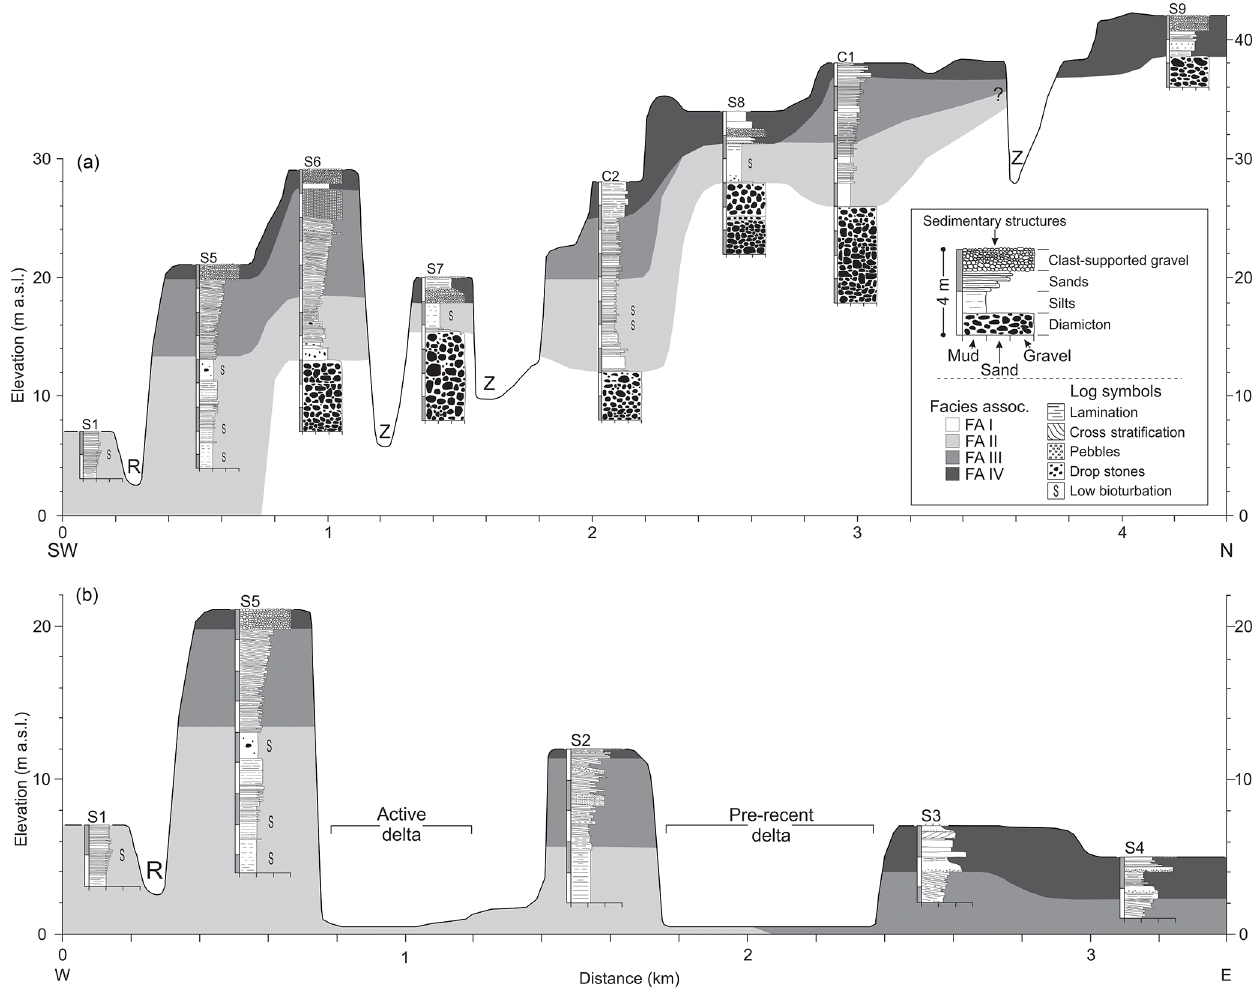
Figure 5. Correlation panel of sedimentary logs and facies associations from (a) the sections along the Zackenberg River (S1 and S5–S9) and cores (C1 and C2) and (b) coastal section (S1–S5). The site identities, above each log, correspond to those in Fig. 1. Z and R indicate the location of the Zackenberg River and minor streams,